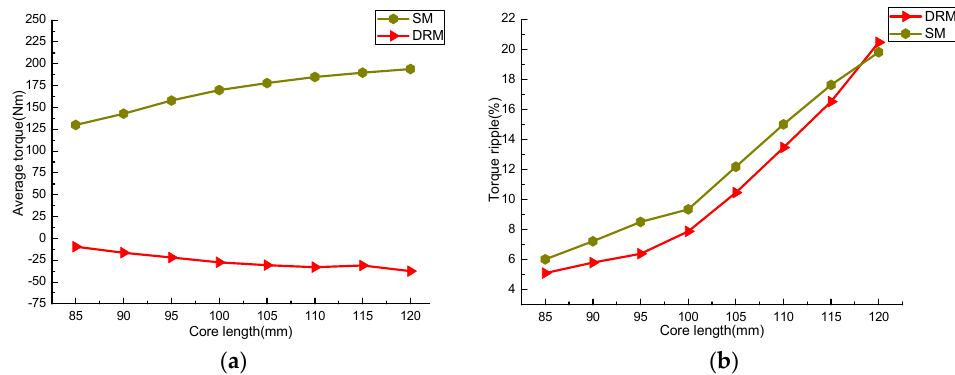
Figure 5. Average torque and torque ripple curves of SM and DRM with different core lengths: ( a ) SM; ( b ) DRM.